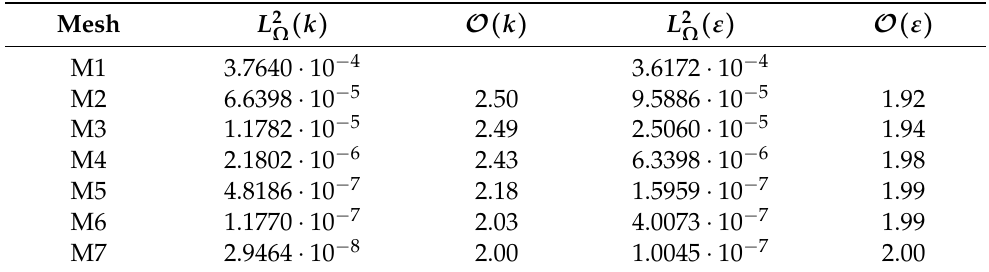
Table 3. Spatial L 2 error norms and convergence rates for the MMS test obtained at time t = 1 using the hybrid FV/FE method for unstructured